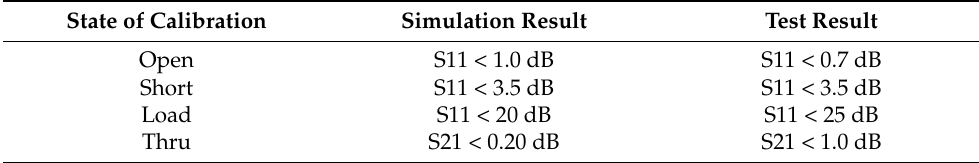
Table 3. Comparison of simulation results and test results.